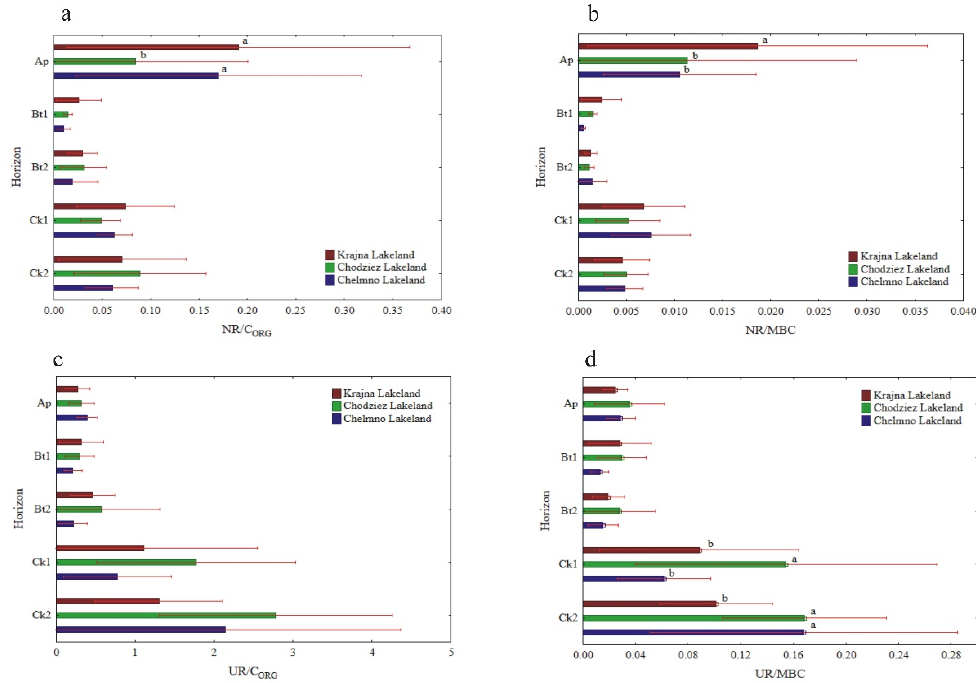
Figure 6. Activity of soil NR and UR at different soil horizons, expressed on an organic carbon (C ORG ) and microbial biomass carbon (MBC) basis; NR/C ORG ( a ), NR/MBC ( b ), UR/C ORG ( c ) and UR/MBC ( d ). Different lowercase letters indicate significant differences ( p < 0.05) between the study sites (within the same genetic horizon).